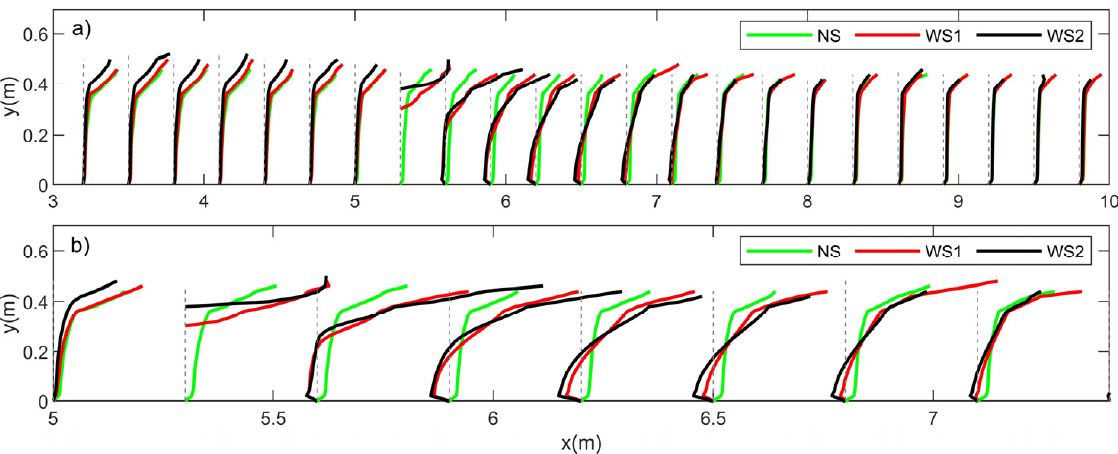
Figure 3. ( a ) Vertical velocity profiles calculated by the mean velocity fields for NS, WS1, and WS2. ( b ) Displays enlarged ( a ). The 0.5 m in the x-axis can be scaled as 1.43 m/s of velocity profiles.